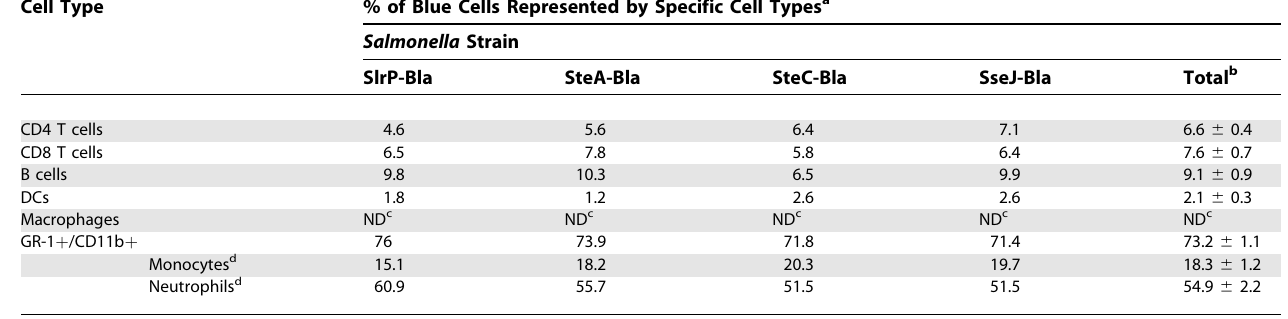
Table 2. Percentage of Blue Spleen Cells Represented by Specific Cell Types from Mice Infected with Effector-Bla Fusion Expressing Salmonella